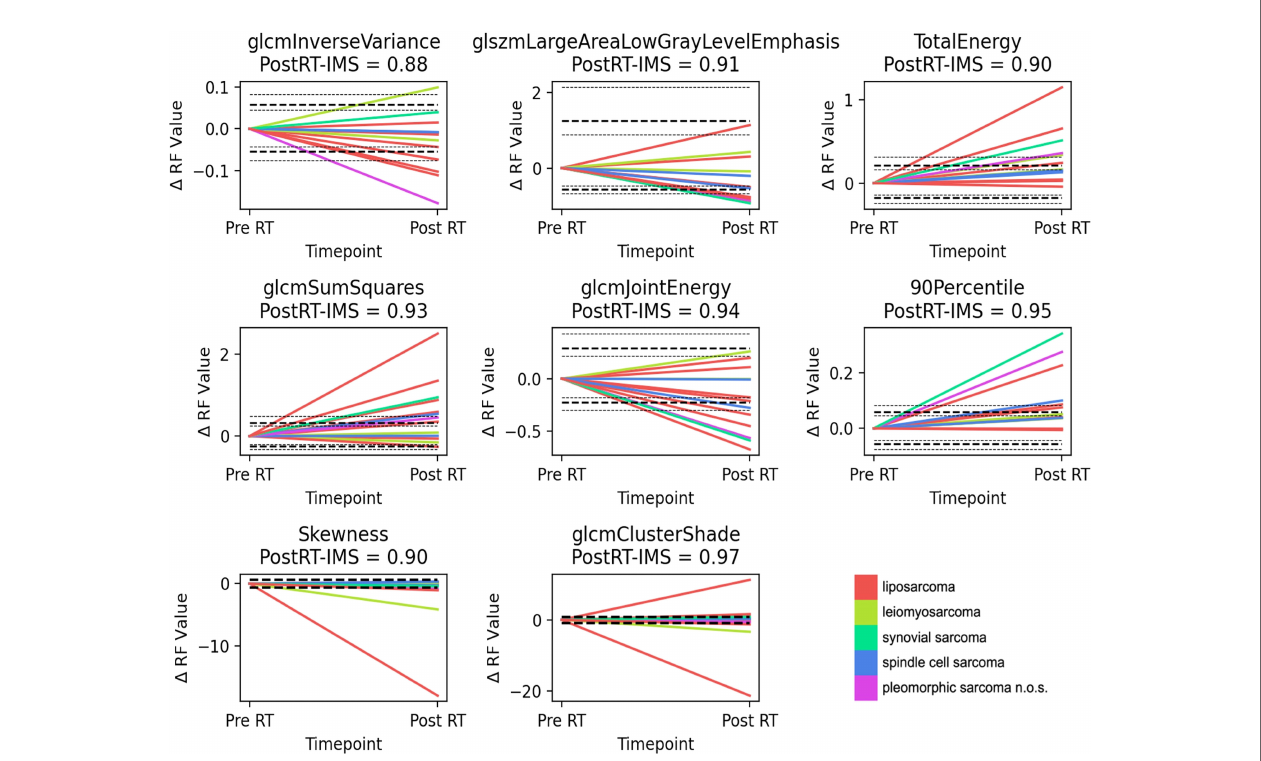
FIGURE 4 | Delta-radiomics plots. Plots showing the fractional change in the radiomic feature value from the fi rst baseline scan to post-radiotherapy treatment, for the ADC-based independent delta-radiomics subset. Interestingly, for a number of features (90 Percentile, Total Energy, and glcmSumSquares), there is a general and signi fi cant increase in these biomarkers after treatment for a number of patients, which renders them promising candidates for further exploration. The LoA and their 95% con fi dence intervals (CI) are shown as dashed and dotted lines, respectively. For Skewness and glcmClusterShade, the repeatability coef fi cient is shown instead. n.o.s., not otherwise speci fi